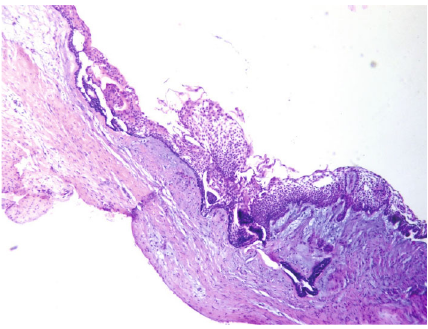
Figure 7: Optical microscopic picture presenting ameloblastomatous epithelium lining the cyst cavity. The specimen was stained with hematoxylin and eosin, magni fi ed 40 times.